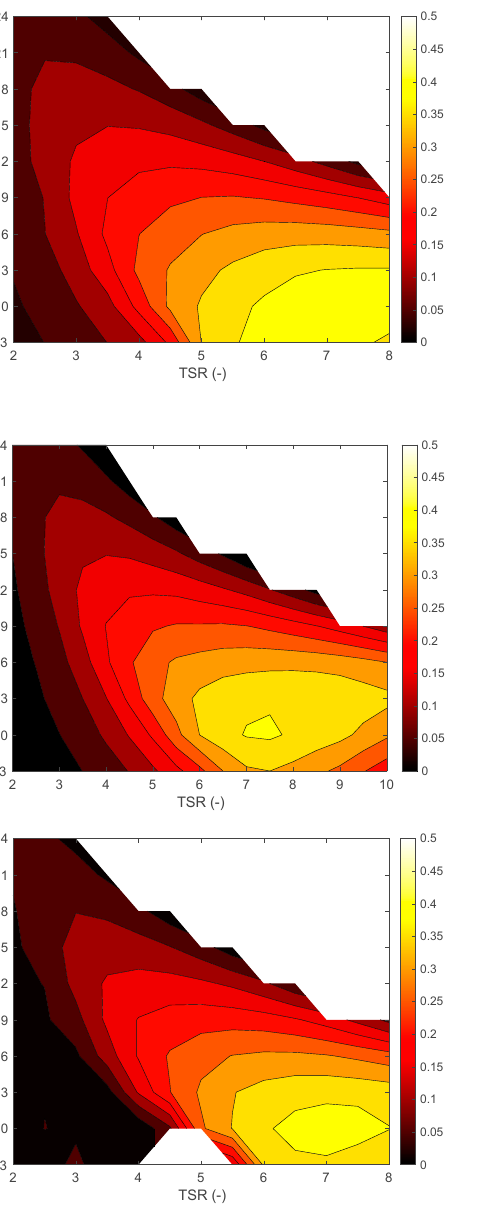
Figure 7. Power coefficient (left) and thrust coefficient (right) of the DTU 10 MW (top), BGF scale model (middle) and WT model (bottom) from the BEM calculations for several values of the tip–speed ratio (TSR) and blade pitch angle. Negative values are omitted.